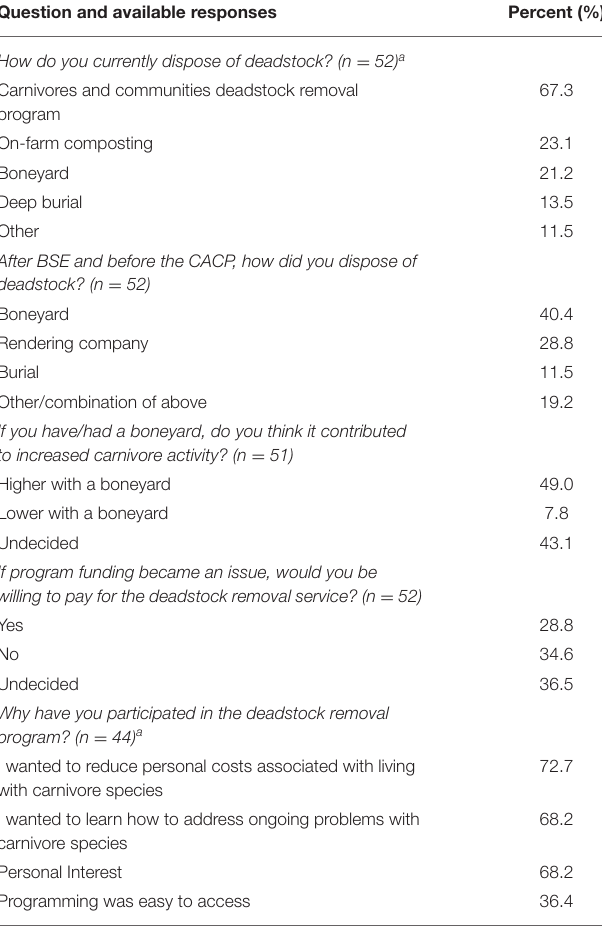
TABLE 5 | Survey questions and available responses, sample size, and percent response to questions related to the Waterton Biosphere Reserve’s Carnivores and Communities deadstock removal